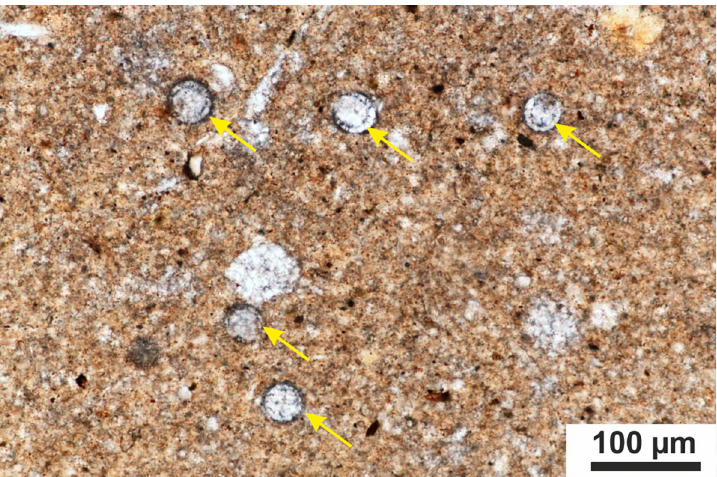
Fig 2. Microscopic view of wackestone rich in Cadosinopsis rehakovii sp. nov. observed in longitudinal and transversal sections (arrows). Thin section 1N, No. Szel 21b.